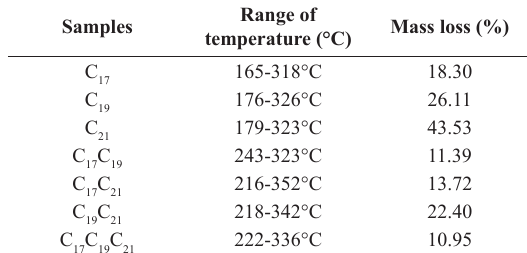
Table 3. Temperature range of deterioration of the surfactants occluded in pores from samples.